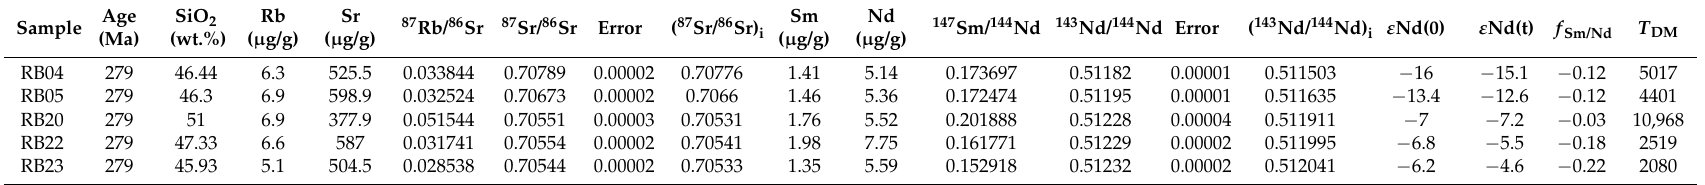
Table A3. Rb–Sr and Sm–Nd isotopes for the Haoyaoerhudong